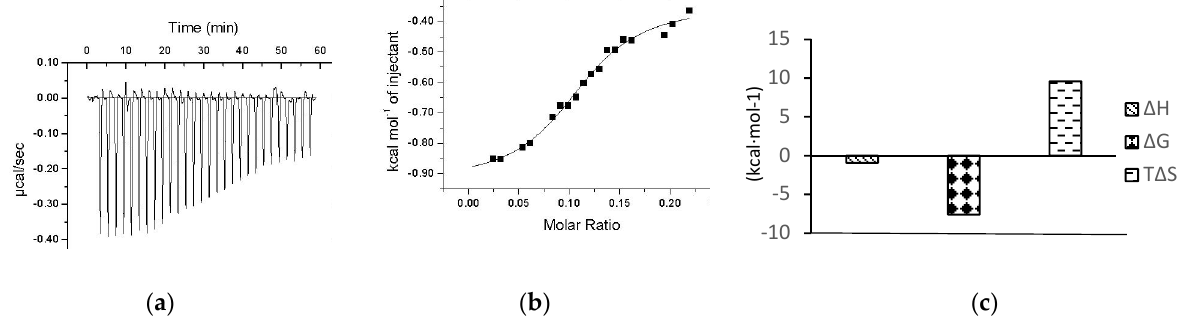
Figure 4. ITC thermogram for the titration of chalcomoracin to α -glucosidase. ( a ) Raw data for titration of 200 μ M chalcomoracin to 20 μ M α -glucosidase at 37 °C, showing the calorimetric response when chalcomoracin is continuously injected into the sample cell. ( b ) Chalcomoracin titration α -glucosidase fitting molar ratio function, enthalpy per mole of CSP80 injected versus the α -glucosidase molar ratio. The solid line represents the best non-linear least-squares fit of the independent binding sites model. ( c ) Chalcomoracin titration thermodynamic parameters of α -glucosidase.